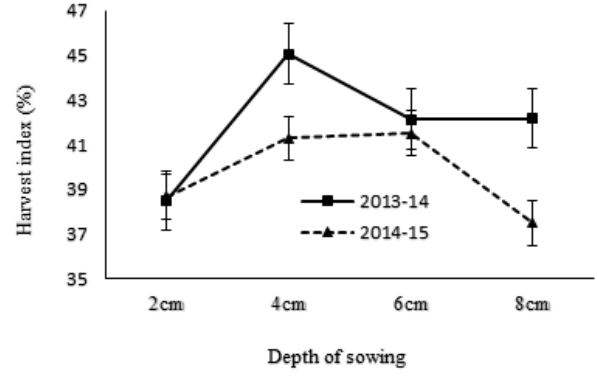
Figure 11 : Straw yield of wheat as affected by sowing depth. Mean (±SD) was calculated from three replicates for each treatment and significantly different at P ≤ 0.05 (LSD test).